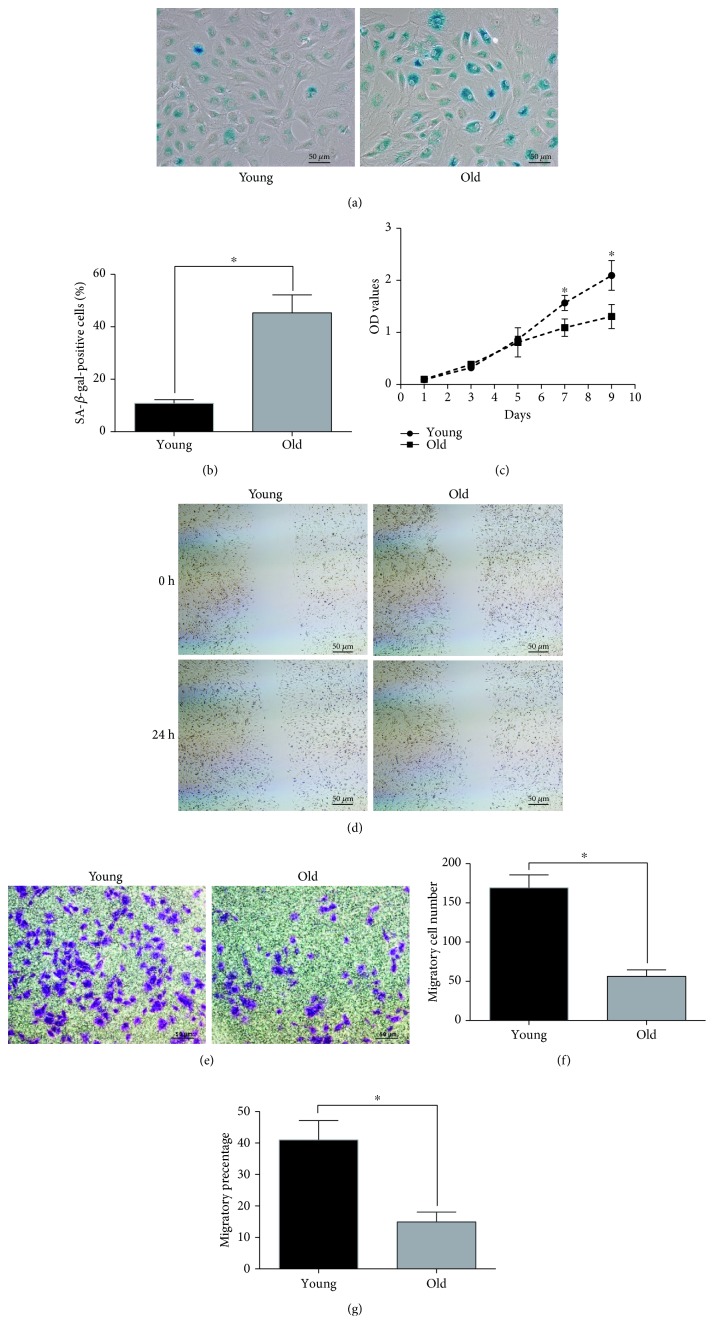
The aging phenotype and migration capacity of young and old NPCs. (a, b) Representative images of SA-β-gal staining for the detection of senescent NPCs from the young and old groups. Quantitative analysis showed that the senescent cell number in the old group was higher than that in the young group. (c) Cell proliferation curve detected by CCK-8 assay. The OD value is higher in the young group after 7 days culture, indicating a higher proliferation capability of young NPCs. (d, g) Cell scratch assay showed declined migrated percentage in old NPCs after 12 h. (e, f) Transwell assay showed a declined migrated cell number in the old group. All samples examined in triplicate. Data are presented as the mean ± SD. ∗
P < 0.05.